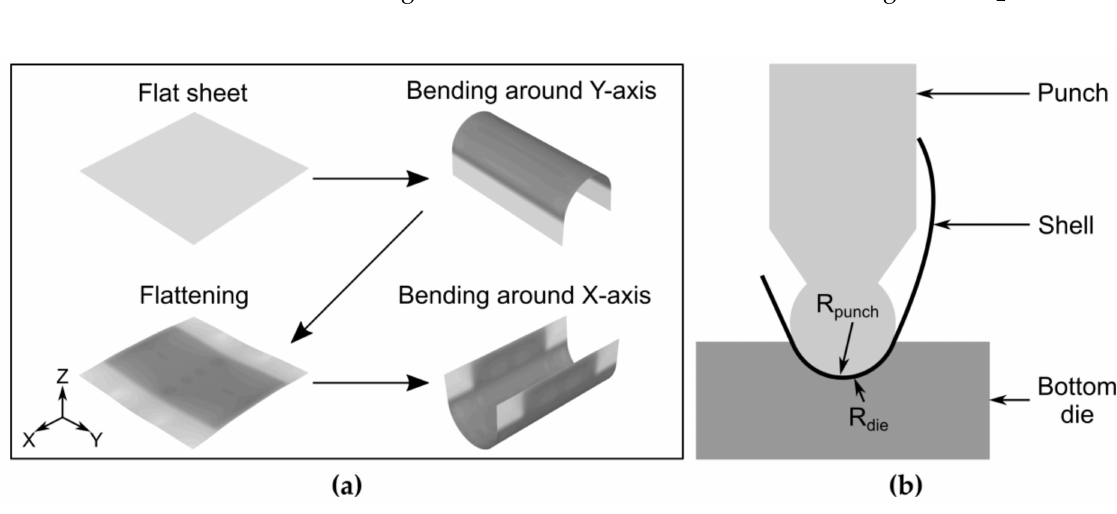
Figure 2. Scheme of the production process of bistable shells ( a ) and schematic representation of experimental setup ( b )